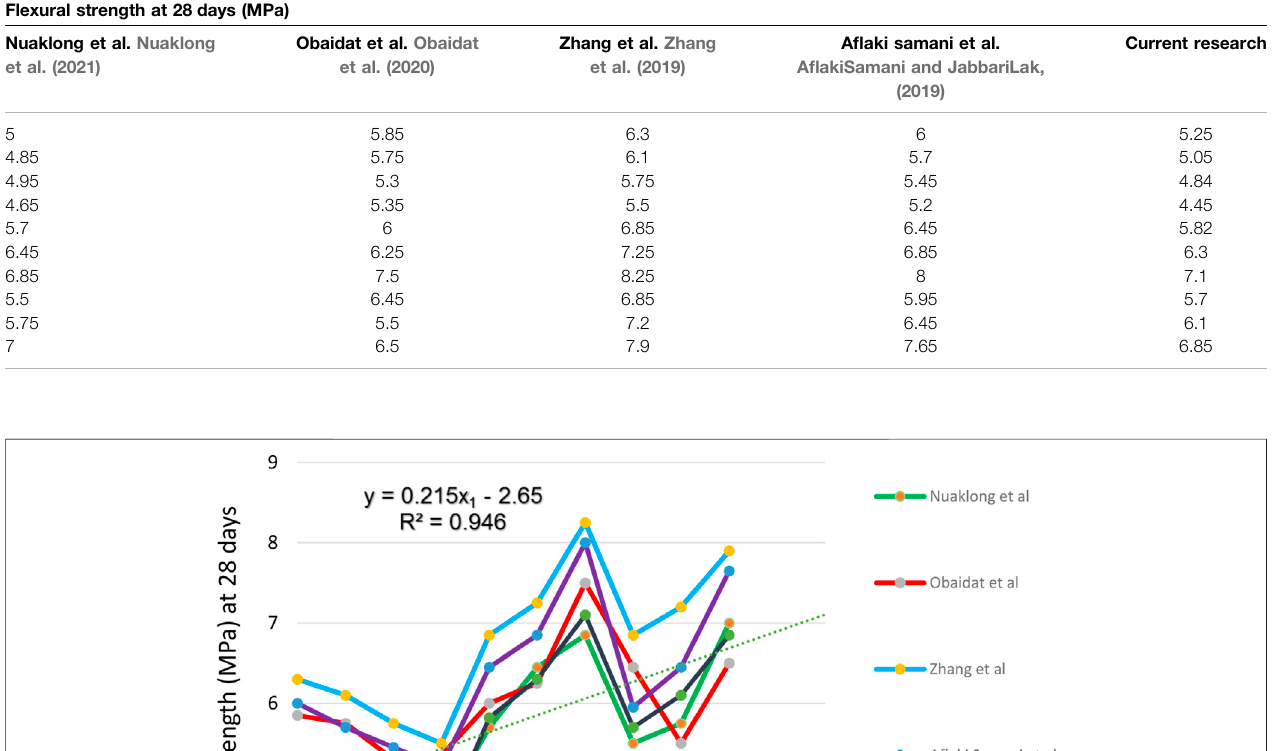
TABLE 7 | Values of Flexural strength from present literature and the current